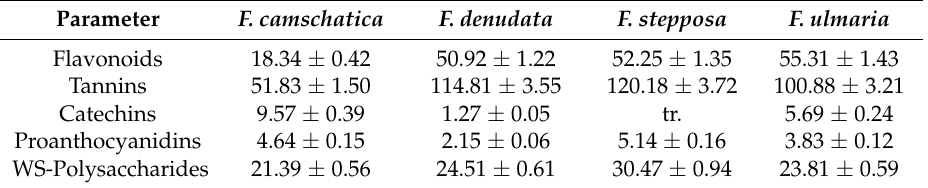
Table 2. General phytochemical characteristics of four meadowsweet teas, mg/100 mL decoction ( ±